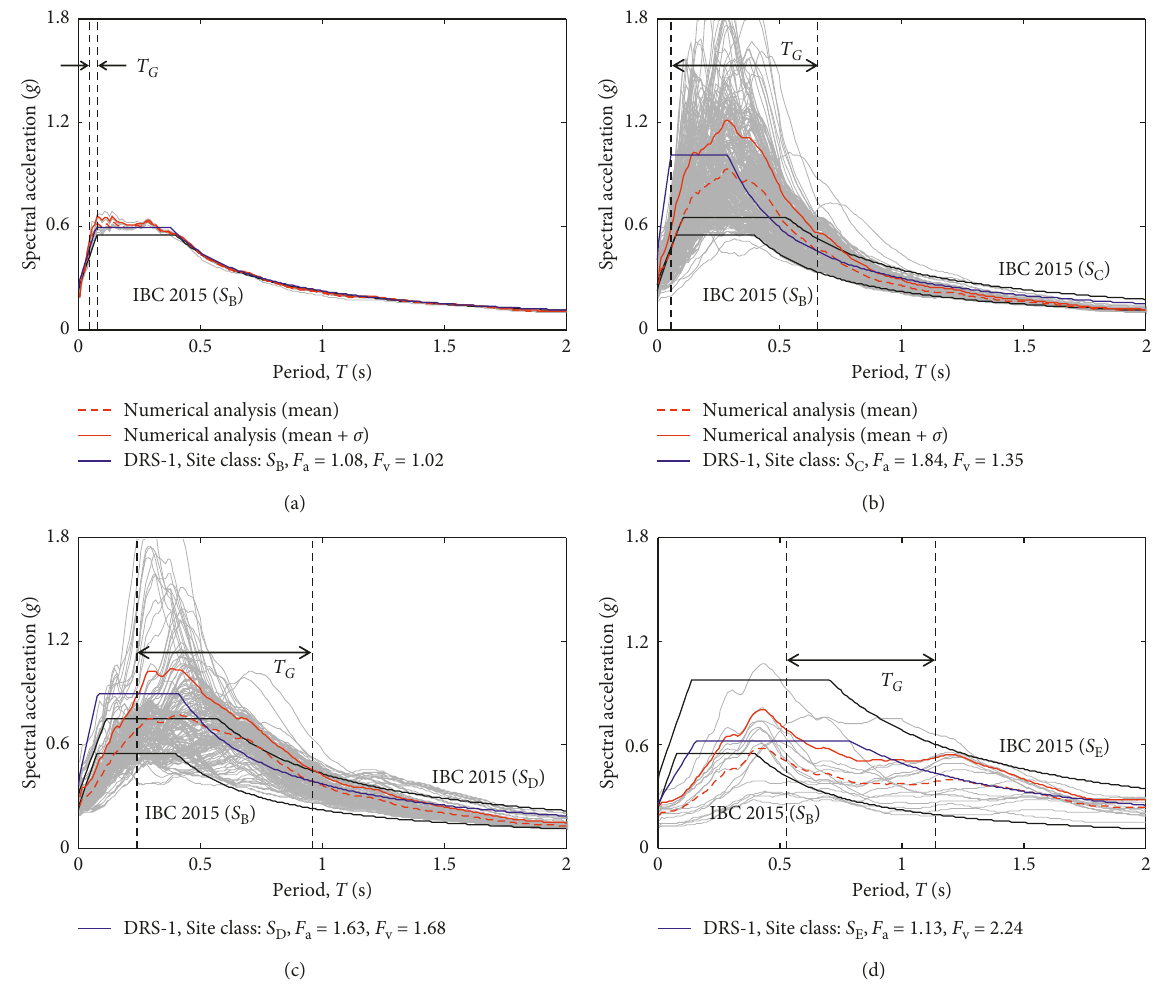
Figure 12: Comparison between numerical analysis results and DRS-1: (a) S